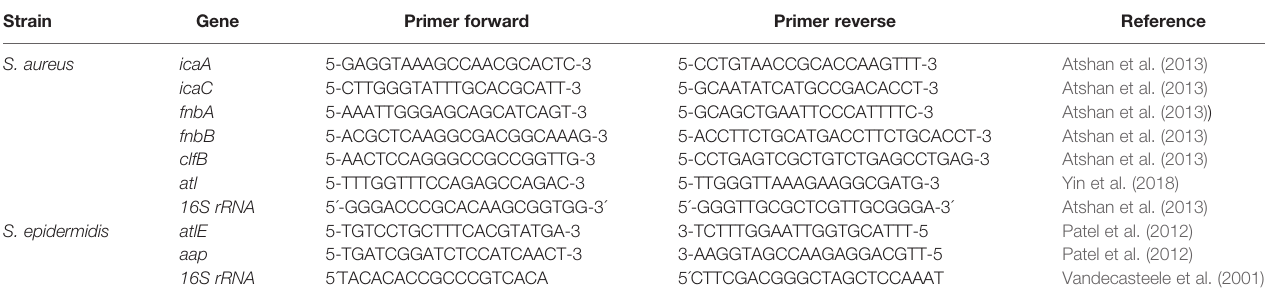
TABLE 1 | Primes used in